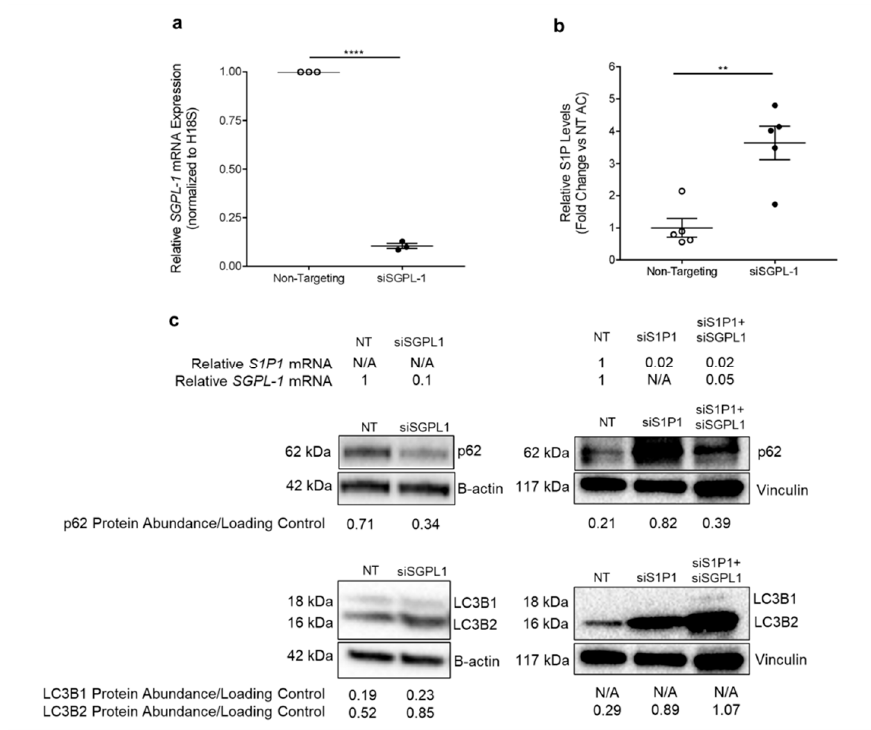
Figure 5. S1P–S1P1 Signaling Effect on HLMVEC Autophagy. ( a ) Relative SGPL-1 mRNA expression in non-smoker HLMVECs (Lonza; n = 3) measured by RTqPCR, normalized to the housekeeping gene human 18S (H18S) using the 2 −∆∆ CT method, expressed as fold-change versus mean control (non-targeting siRNA) expression. **** p < 0.0001; 2-tailed unpaired Student’s t -test. ( b ) Relative S1P levels in non-smoker HLMVECs (Lonza; n = 5) transfected with siSGPL-1 for 72 h, measured by mass spectrometry. ** p = 0.002; 2-tailed unpaired Student’s t -test. All graphs show data points, each representing an individual donor; horizontal lines are mean ± SEM. ( c ) Representative Western blots of LC3B and p62 protein abundance in non-smoker HLMVECs (Lonza; n = 1) transfected with non-targeting (NT) siRNA, siSGPL-1 (10 µg protein/well), siS1P1 (20 µg protein/well), or co-transfection with siS1P1 and siSGPL-1 (20 µg protein/well) for 72 h. B-actin and vinculin were used as loading controls. Written above is the relative expression of S1P1 and SGPL-1 mRNA after NT or siRNA transfection, by RTqPCR and normalized to housekeeping gene H18S using the 2 −∆∆ CT method. Below is the associated densitometry analysis, calculated as the ratio of protein abundance to loading control.